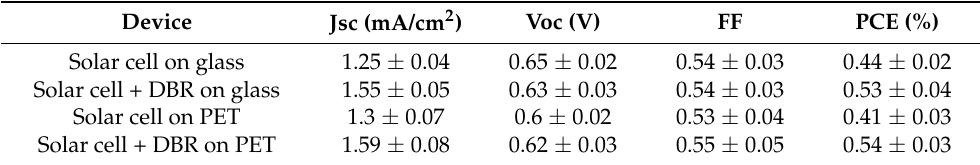
Table 2. Device performance of transparent solar cells with DBR and different substrates. Device